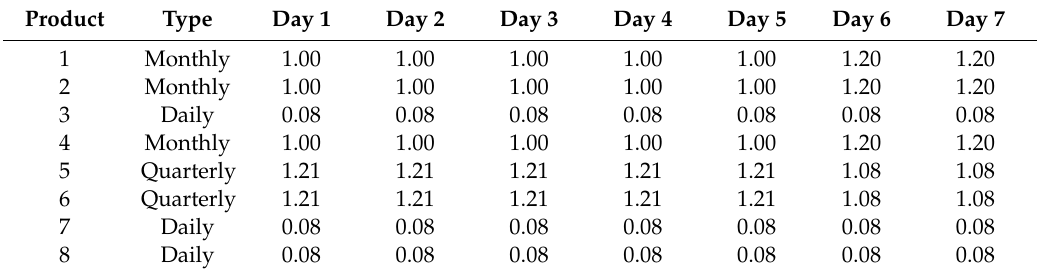
Table 11. Open access capacity market—fixed term coe ffi cients by duration type and day.